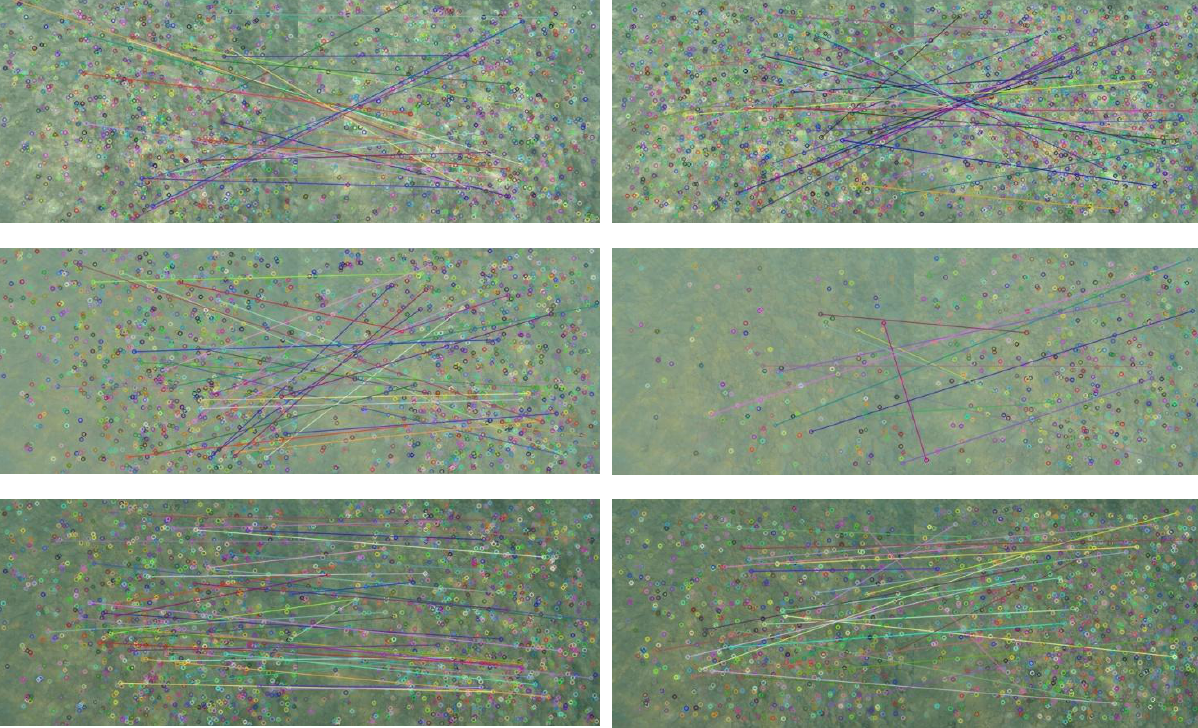
Figure 7. SIFT (left) and SURF (right) matched points on the original uncorrected imagery (first row), the corrected ct imagery (second row) and the corrected orig. imagery (third row) of the dataset